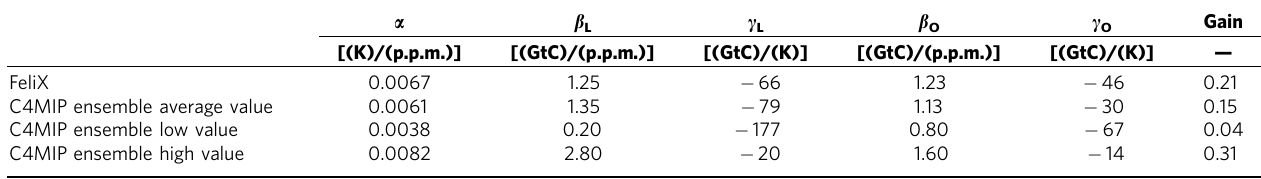
Table 3 | Parameters describing chemical and climate feedback to land and ocean